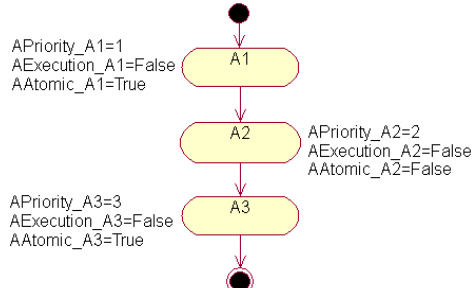
Fig. 9. Tags initialization before implementing the corresponding CPN